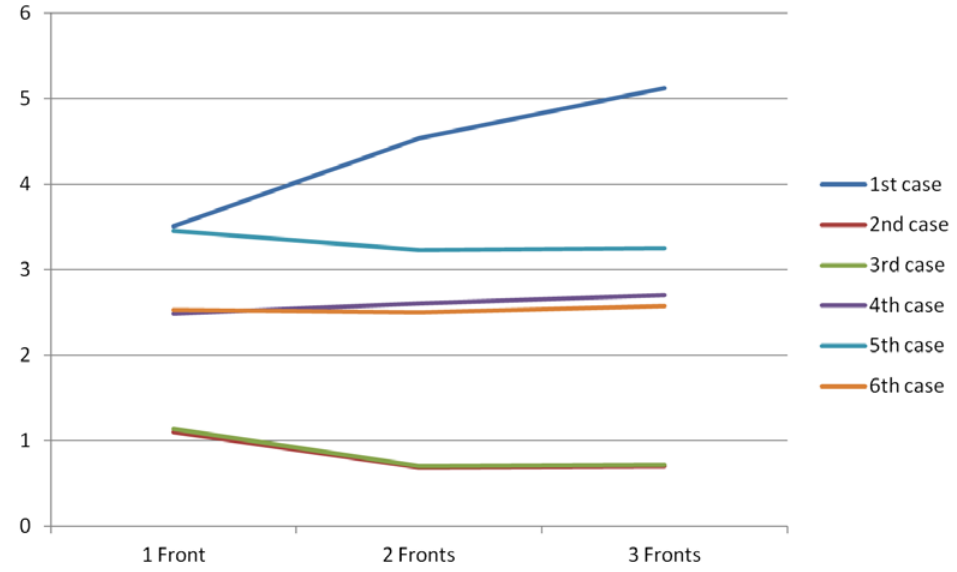
Figure 8. MAPE [%] for different cases of Pareto front utilization (Tables 2, 4, 8, 10, and 12).